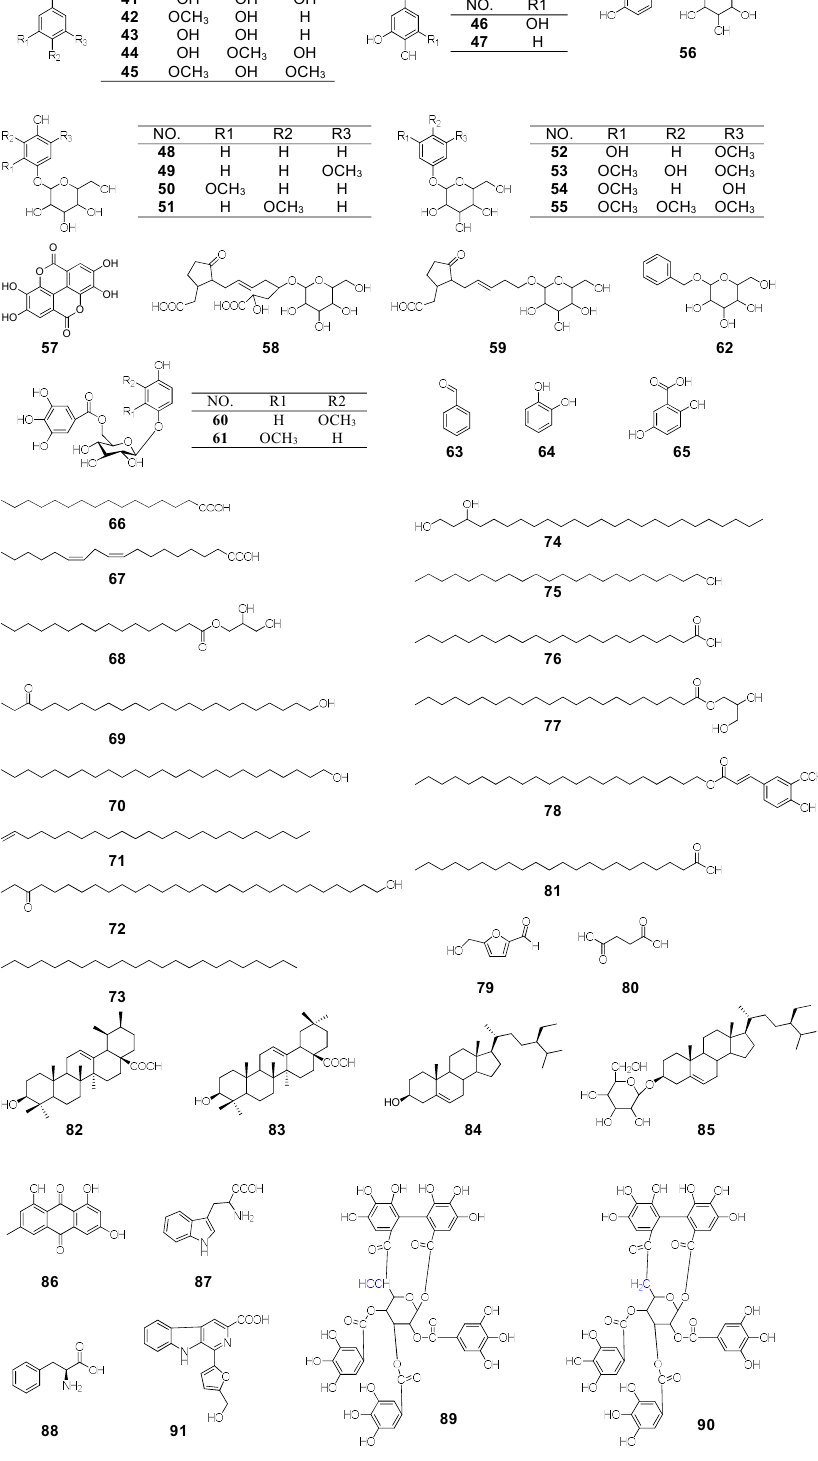
Figure 2. The chemical structure of compounds from P. capitatum (continued).